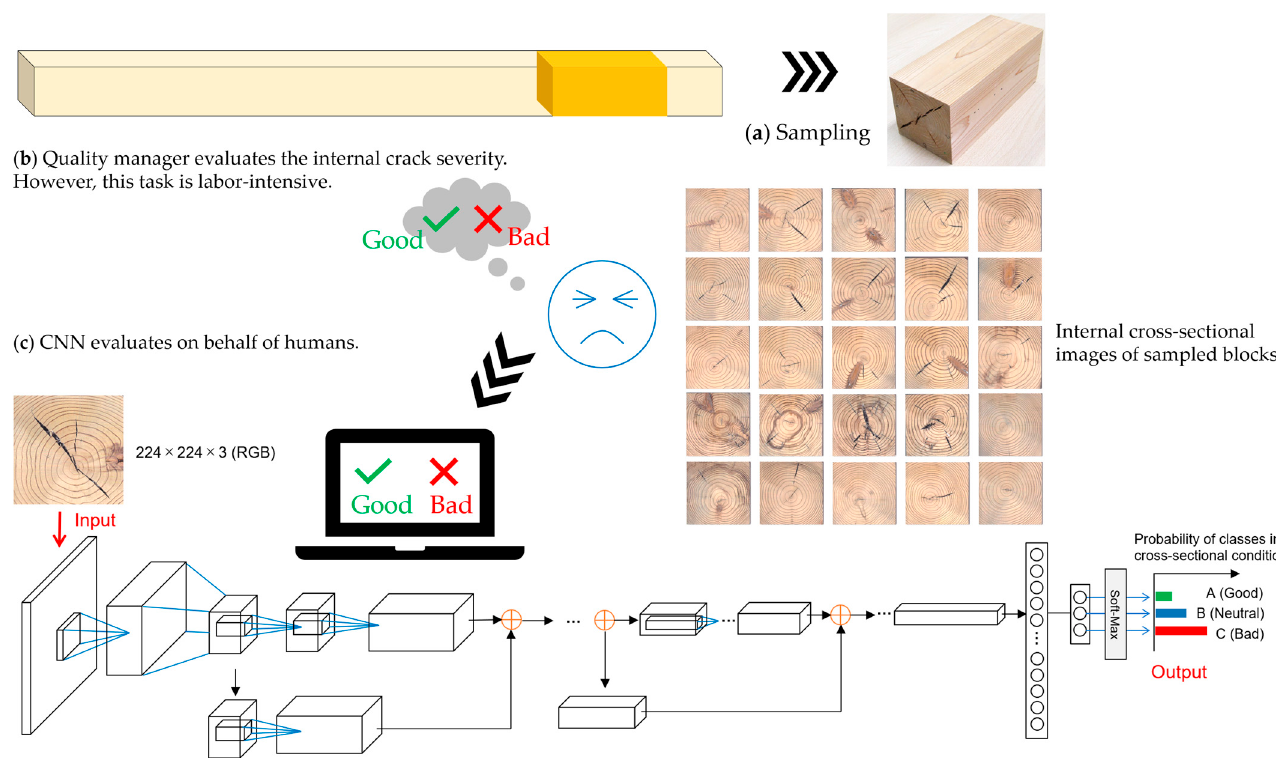
Figure 2. Process of substituting a human with a convolutional neural network (CNN) to evaluate timber crack severity. ( a ) Sample block extraction; ( b ) Human evaluation is burdensome; ( c ) CNN evaluation of crack severity.